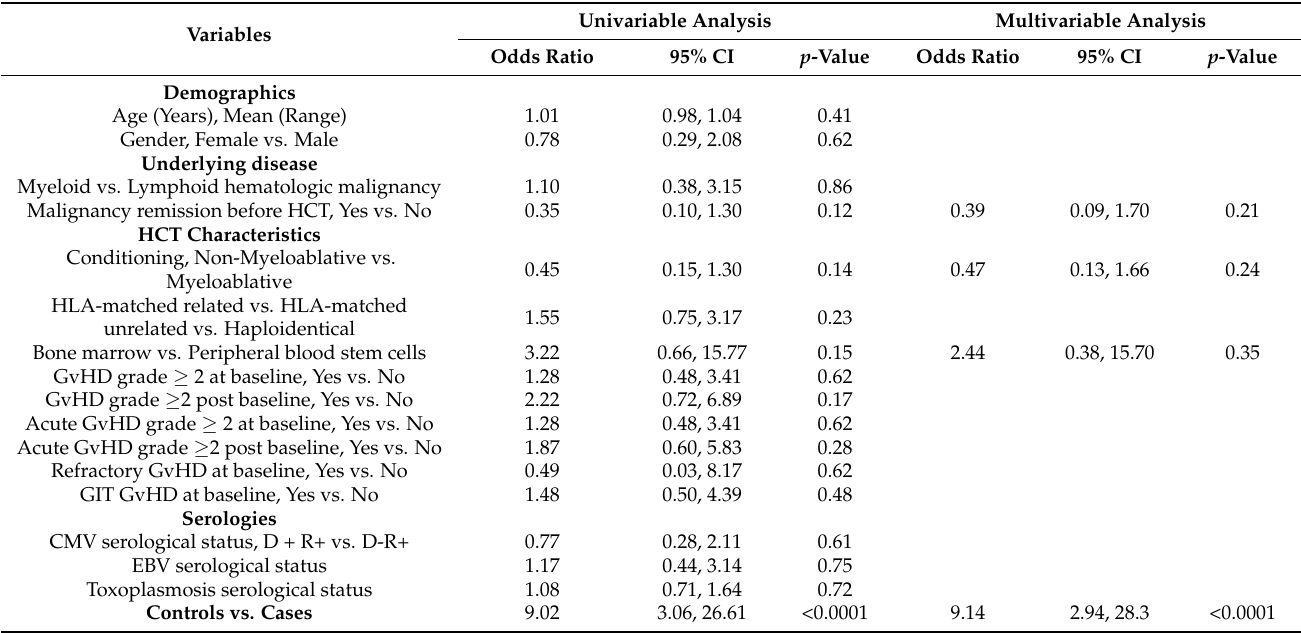
Table 3. Risk factors analysis for clinically significant CMV